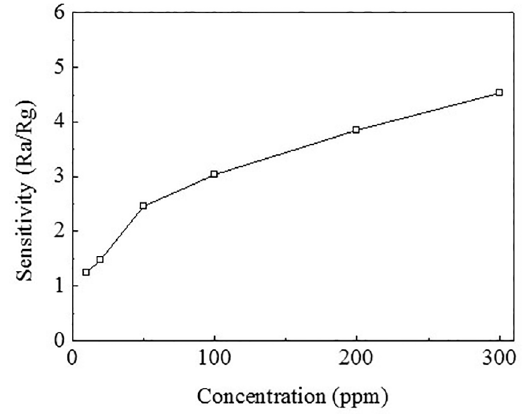
Figure 4: Sensitivity of PbS sensor to different ethanol concentrations.